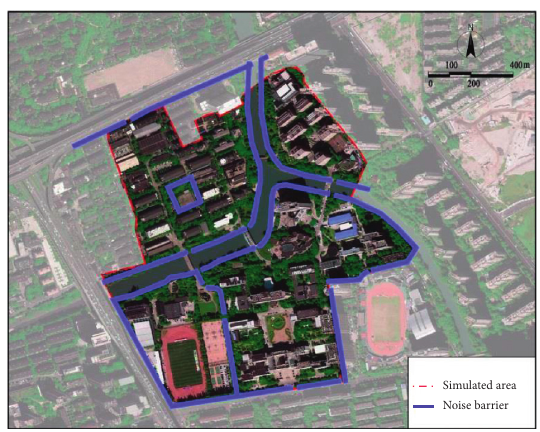
Figure 7: Diagram of noise barrier installation in the simulation zones.